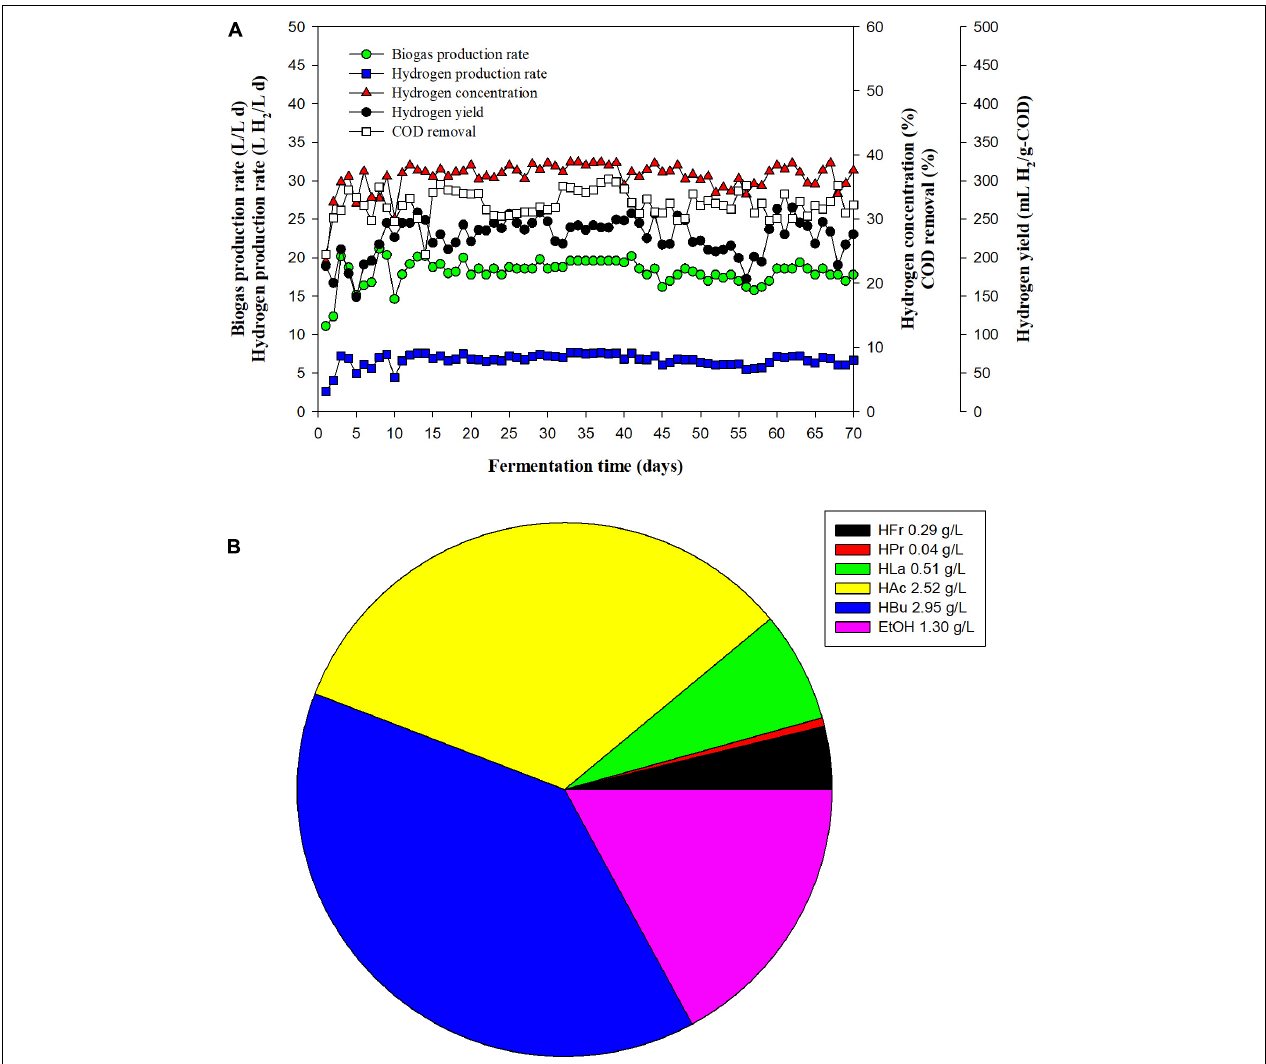
FIGURE 3 | Fixed-bed reactor (FBR) performance with respect to (A) biogas production rate, hydrogen production rate, hydrogen concentration, hydrogen yield, and COD removal, and (B) soluble metabolite product production from the co-digestion of oil palm trunk hydrolysate and slaughterhouse wastewater in long-term operation of the FBR under an optimal hydraulic retention time (6